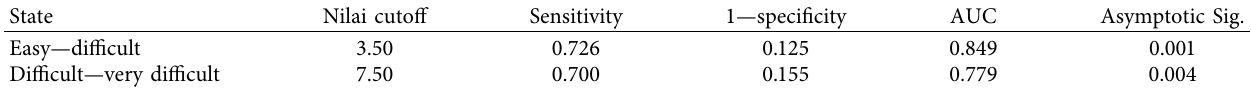
Table 2: ROC curve summary table.